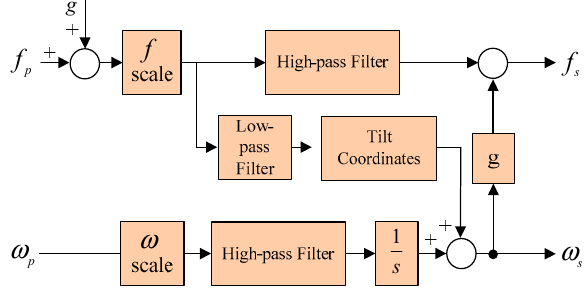
Figure 2. Block diagram of classical washout algorithm.